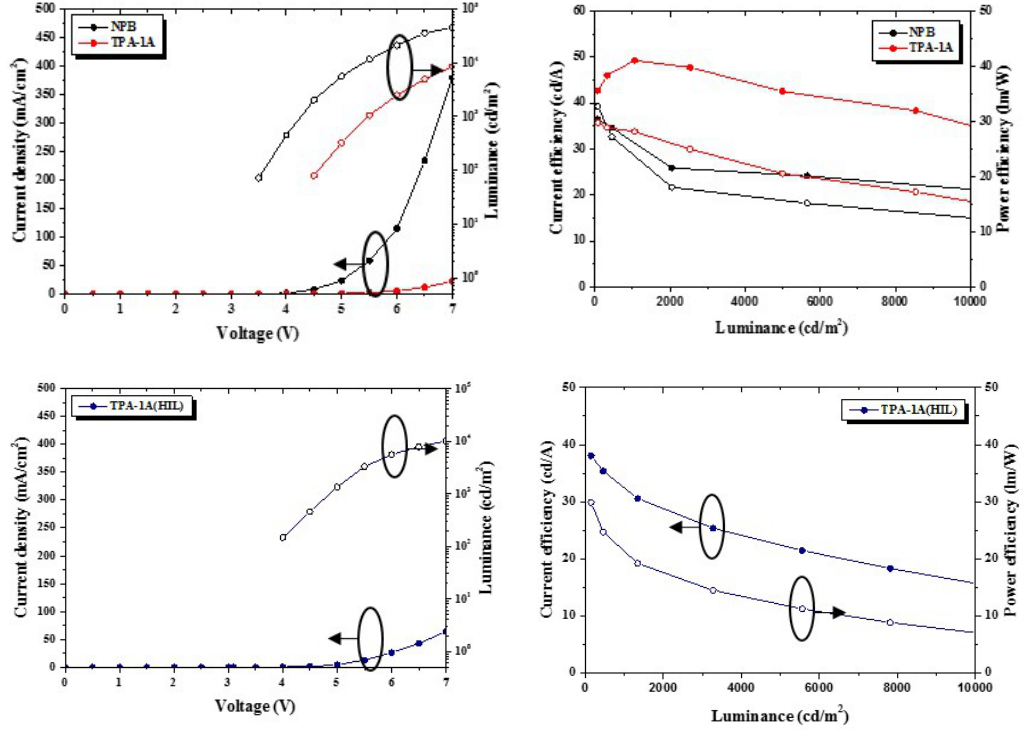
Figure 5. J-V-L, luminescence-current, and power efficiency curves of TPA-1A-based devices.